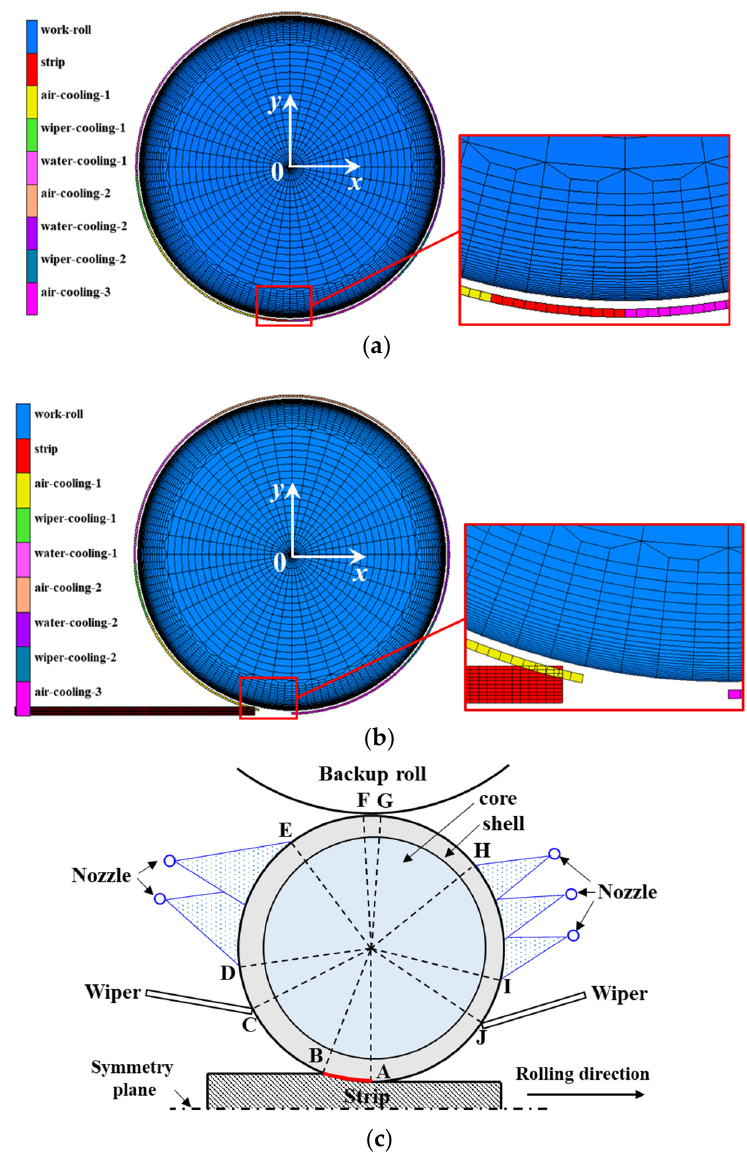
Figure 1. ( a ) FEM model without hot strip used for thermal stress analysis, ( b ) FEM model with hot strip used for thermo-mechanical stress analysis, ( c ) schematic of thermal and mechanical boundary conditions of the work roll during hot strip rolling.